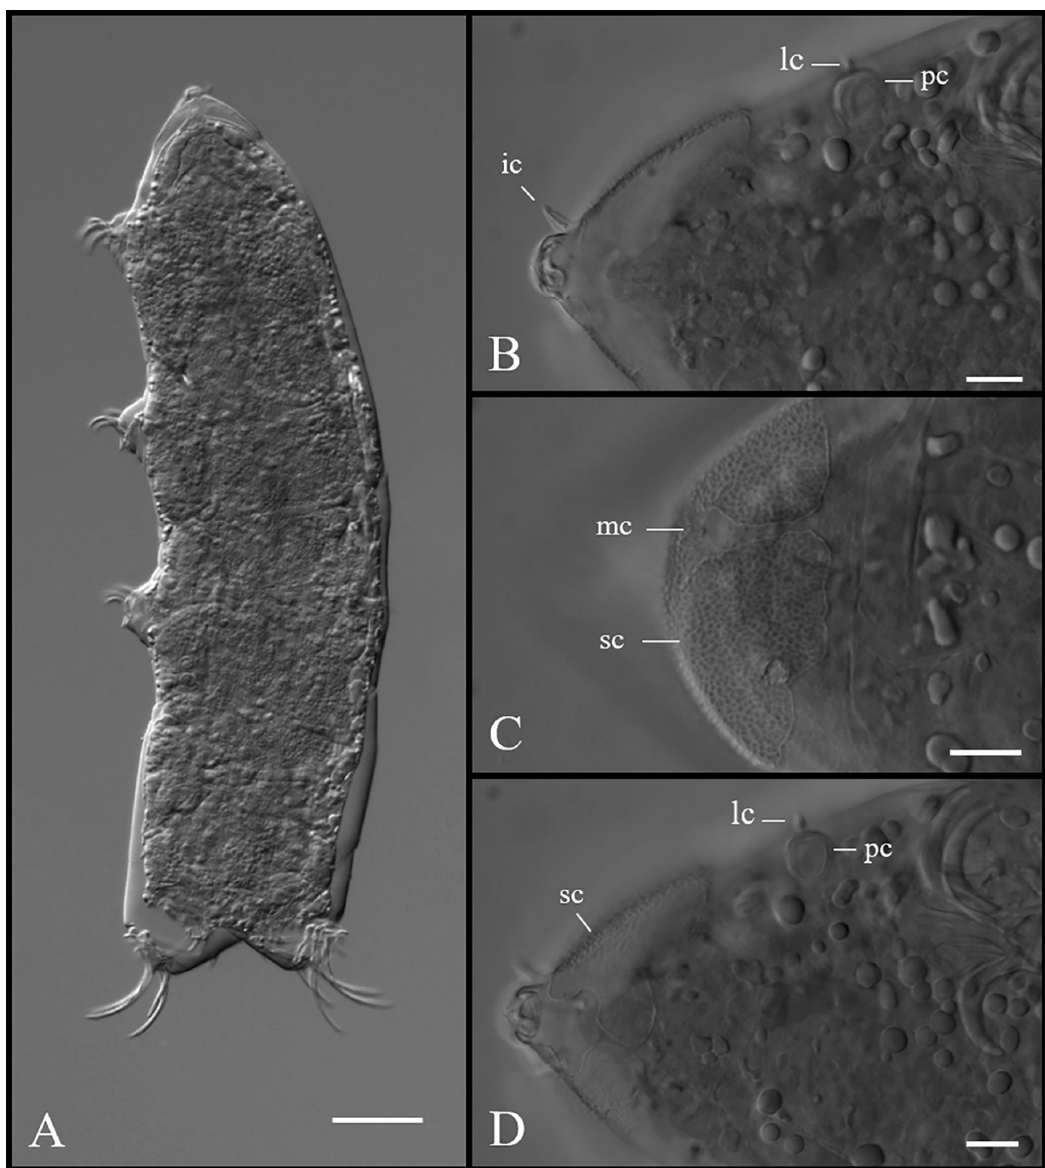
Figure 10. Coronarctus yurupari sp. nov. ( A ) Habitus; ( B ) Ventral view of the head showing the internal cirrus, primary clava, and lateral cirrus A ; ( C ) Dorsal lobes of secondary clavae, notice the punctuation, and location of the median cirrus; ( D ) Ventral lobes of secondary clavae, primary clava, lateral cirrus A, and claws on legs I are also visible. Abbreviations: ic—internal cirrus; lc—lateral cirrus A ; mc—median cirrus; pc—primary clava; sc—secondary clava. Scale bars: 10 µm. Trunk cirri B (5.0 µm), C (16.0 µm), and E (25.0 µm) are present as typical of the genus. Each trunk cirrus consists of a very short cirrophore, accordion-like scapus, and flagellum, which is particularly short on cirrus B , tapering into a blunt tip.